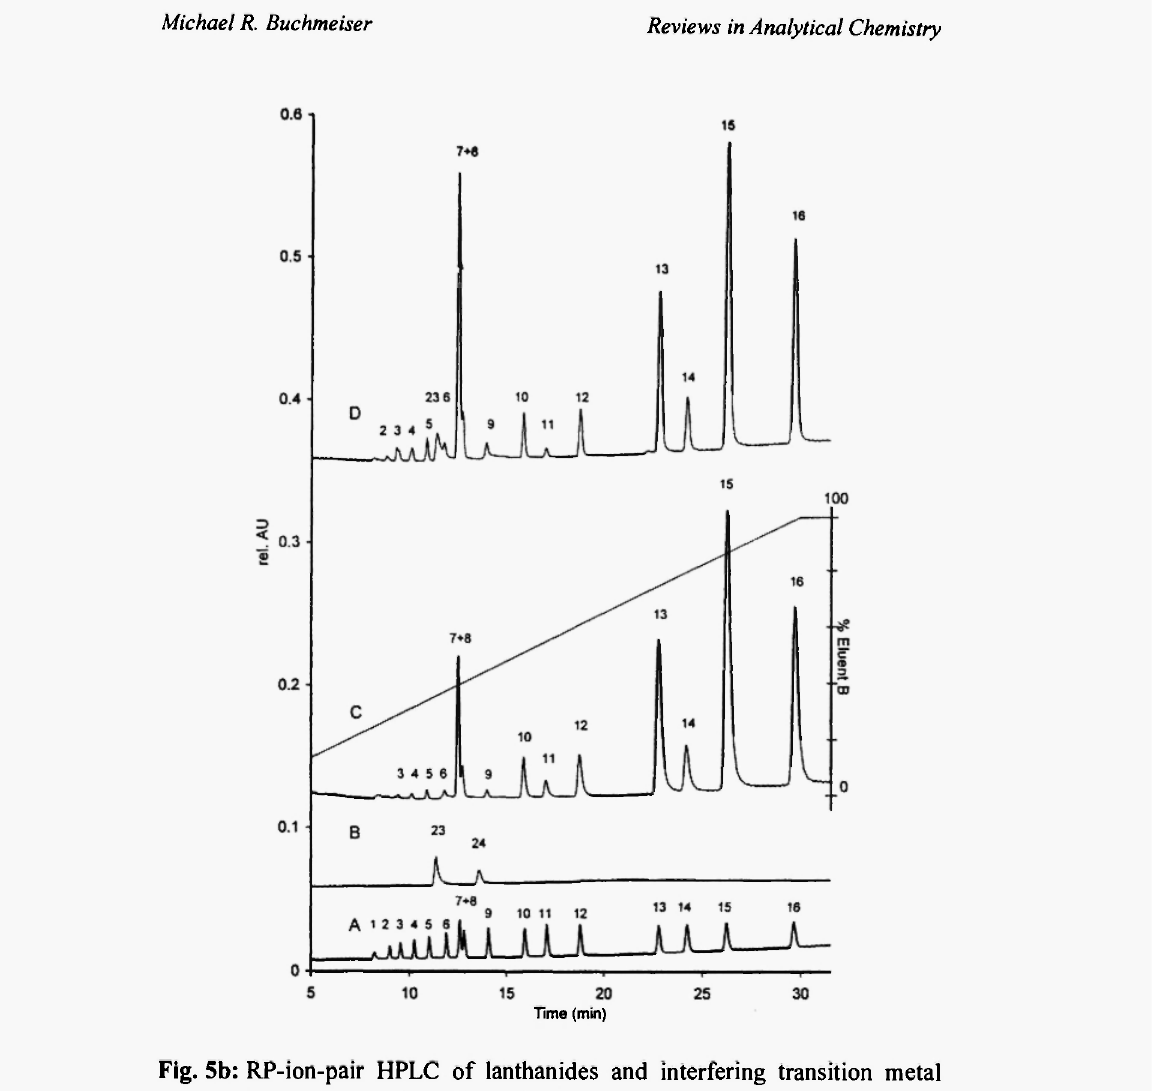
Fig. 5b: RP-ion-pair HPLC of lanthanides and interfering transition metal ions after on-line SPE using arsenazo III. For chromatographic conditions refer to the experimental section. A: lanthanide standard (inj. vol. 10 μΐ, c = 10 μ§/υι1 each); B: U0 22+ and Th 4+ standard (inj. vol. 10 μΐ, c = 20 μg/ml each), C: GSR-3 basalt digest, D: GSR-1 granite digest. Peak order: Sc 3+ (1), Lu 3+ (2), Yb 3+ (3), Tm 3+ (4), Er 3+ (5) HO 3+ (6), Y 3+ (7), Dy 3+ (8), Tb 3+ (9), Gd 3+ (10), Eu 3+ (11), Sm 3+ (12), Nd 3+ (13), Pr 3+ (14), Ce 3+ (15), La 3+ (16), Th 4+ (23), U0 2 2+ (24). Reprinted with permission from ref. 78. Copyright 2000 American Chemical Society.